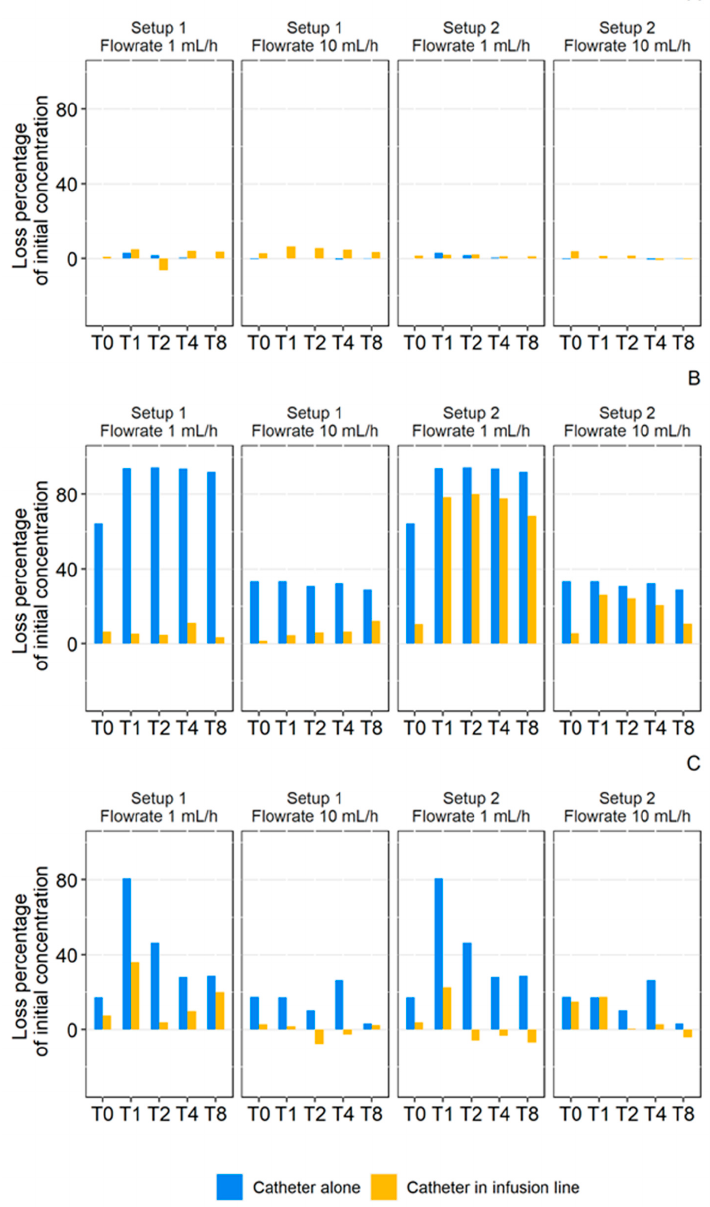
Figure 9. Comparison of the calculated loss percentage of initial concentration in paracetamol ( A ), diazepam ( B ), and insulin ( C ) during 1 mL/h and 10 mL/h through a catheter alone (Blue) or a catheter in an infusion line (Orange). (Setup 1: polypropylene syringe + polyvinyl chloride extension set + Turbo-Flo polyurethane catheter. Setup 2: polypropylene syringe + polyethylene coextruded with polyvinyl chloride extension set + Turbo-Flo polyurethane catheter. T0–T8: different analysis times: immediately after purging (T0), then after 1 h (T1), 2 h (T2), 4 h (T4), and 8 h (T8) of infusion.